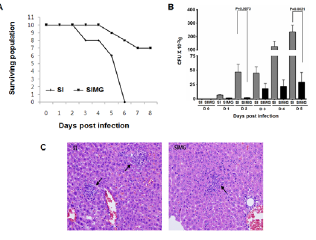
Figure 3. Therapeutic effects of MG treatment on mice infected with Salmonella . (A) the survival of mice (n=10, per group) treated or untreated with MG, infected with WS- 5, (B) Effects of feeding MG on fecal shedding of S . Typhimurium (CFU/g) from mice. (C) Histopatho- logical changes in liver of Salmonella -infected and Salmonella -infected treated MG. Salmonella -infected (SI) and Salmonella -infected + MG (SIMG). All data with P , 0.05 were considered significant.